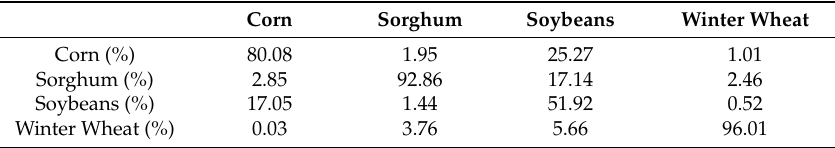
Table 8. Confusion matrix of study area 3 based on NDVI + mLSTI time series